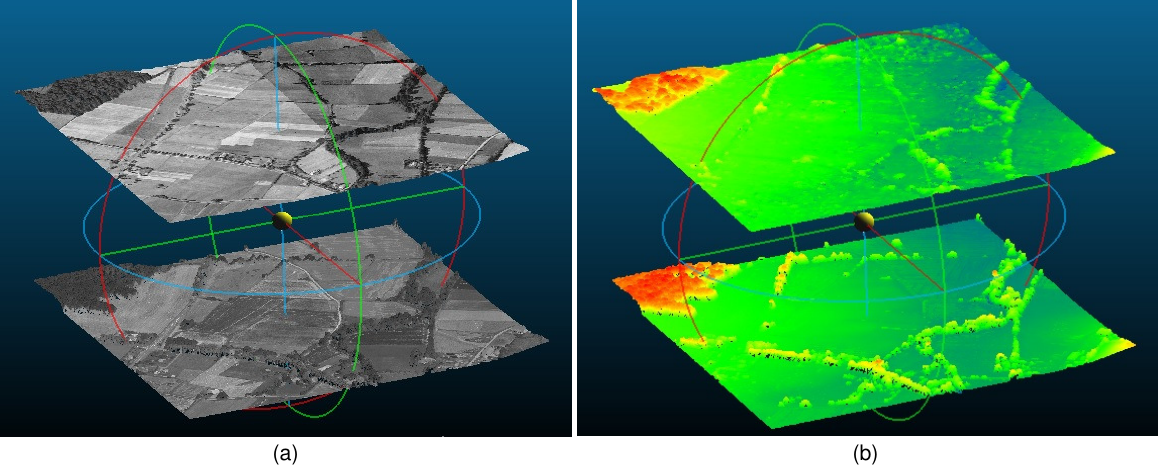
Figure 3. The 3D point clouds obtained by associating orthoimages and DSMs for the dataset Fabas. (a) P 3 D,old with N old = 1 Mpts situated in the upper side of the image, P 3 D,new with N new = 1 Mpts illustrated in the down side of the image; (b) input point clouds, P 3 D,old , P 3 D,new , displayed with respect to elevation